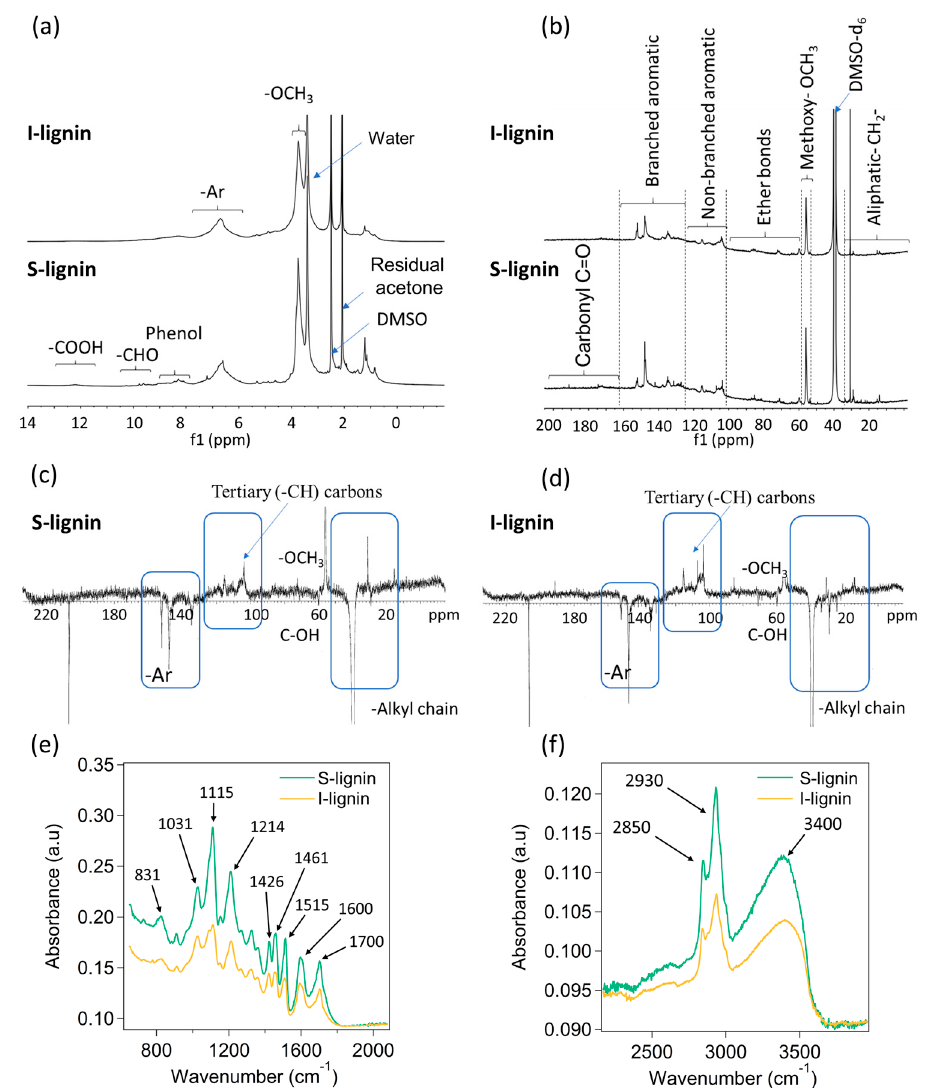
Figure 1. Structural characteristics of I-lignin and S-lignin: ( a ) Proton nuclear magnetic resonance ( 1 H-NMR), ( b ) 13 C NMR, ( c,d ) Attached proton test (APT) 13 C-NMR, and ( e,f ) FTIR data.